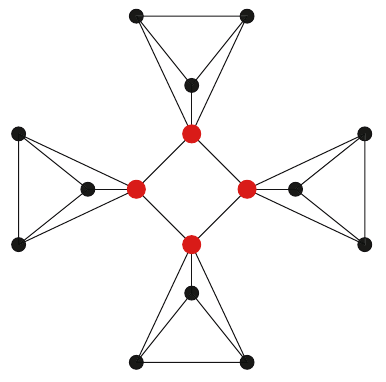
Figure 1: The corona graph C 4 K 3